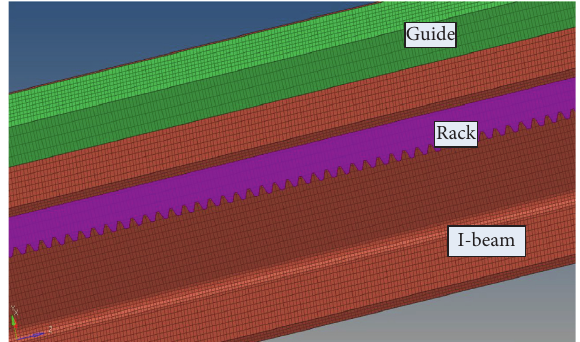
Figure 10: 3D HyperMesh mesh screenshot of beam.